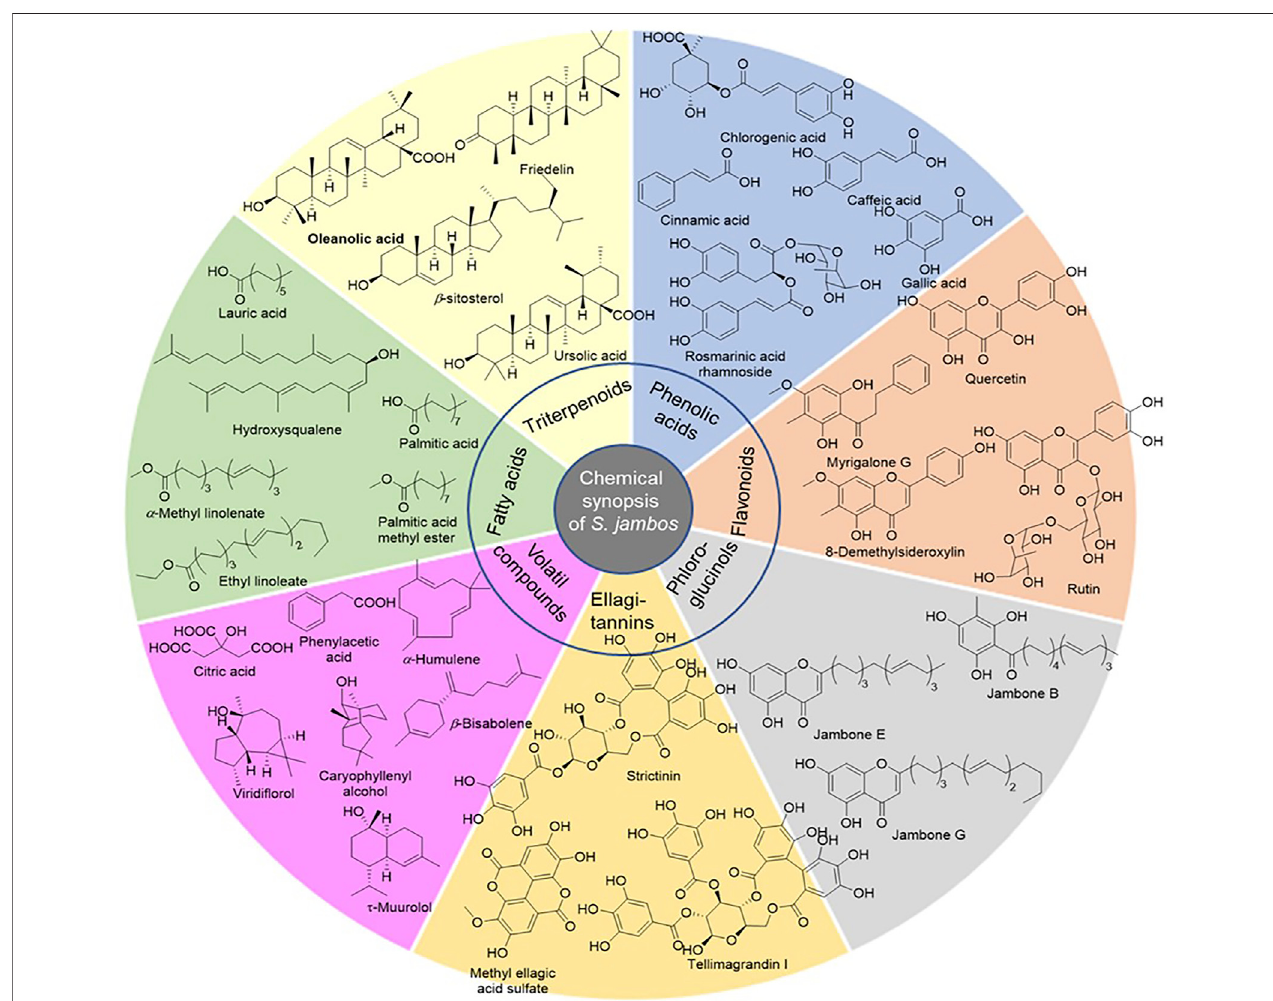
FIGURE 2 | Selected secondary metabolites from S. jambos